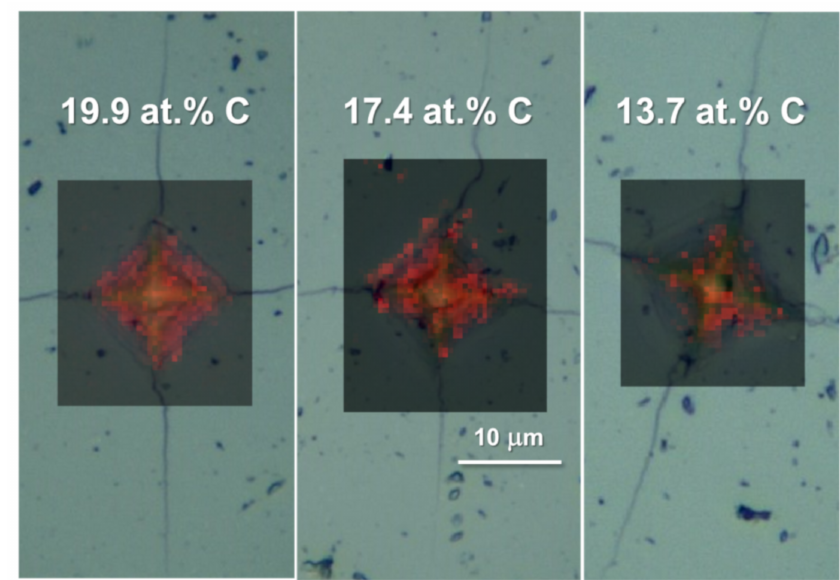
Figure 2. Pseudo-color intensity maps generated by an area-map of Raman spectroscopy with a 633 nm